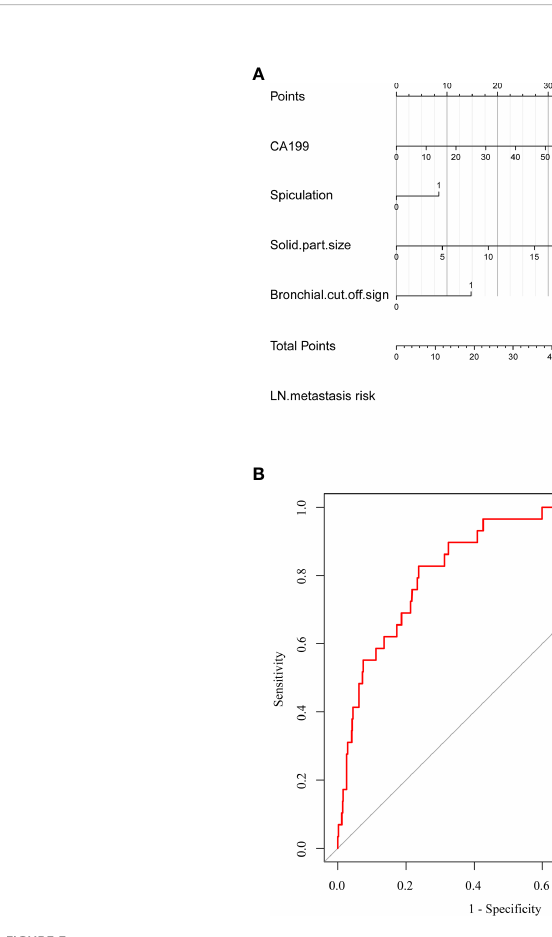
FIGURE 3 Nomogram and its ROC curve for preoperatively predicting the risk of lymph node metastasis in PSILA. (A) The nomogram built for preoperatively predicting the risk of lymph node metastasis. Points of four indicators (CA199, solid part size, spiculation, and bronchial cutoff signs) can be obtained, and then, the sum (total points) of four “ points ” can be converted into the risk probability of lymph node metastasis. (B) The ROC curve of the nomogram. The area under the ROC curve (AUC) was used to assess the predictive performance of the